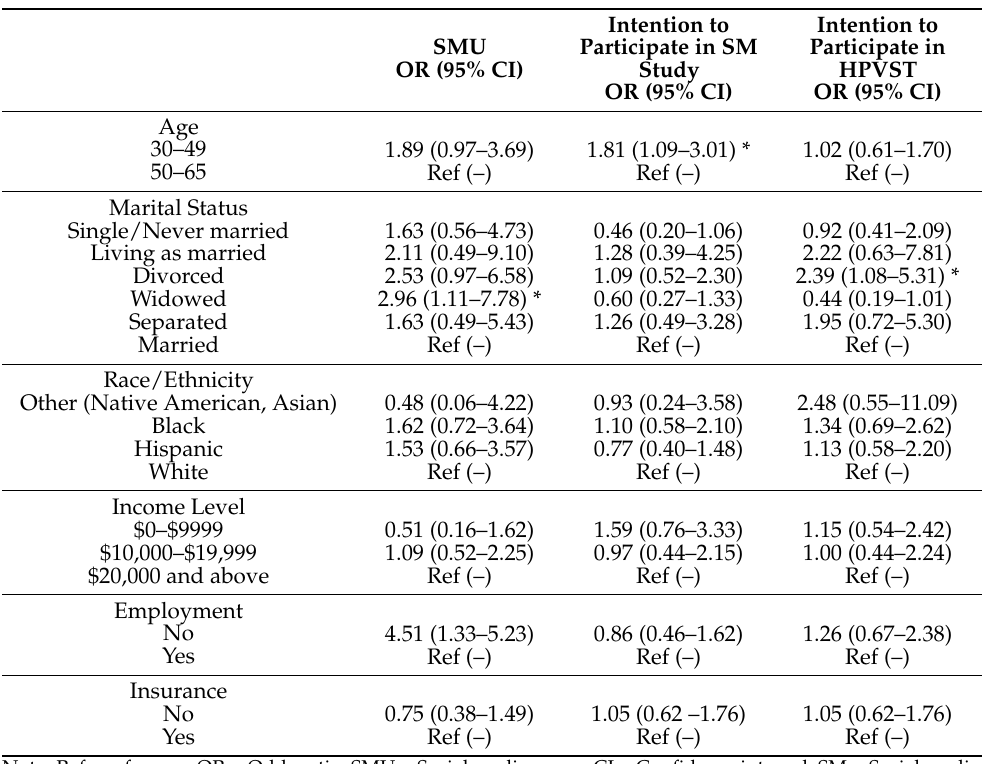
Table 2. Multinomial logistic regression models of social media usage, intention to participate in social media study, and intention to participate in HPV self-testing by selected covariates ( n =